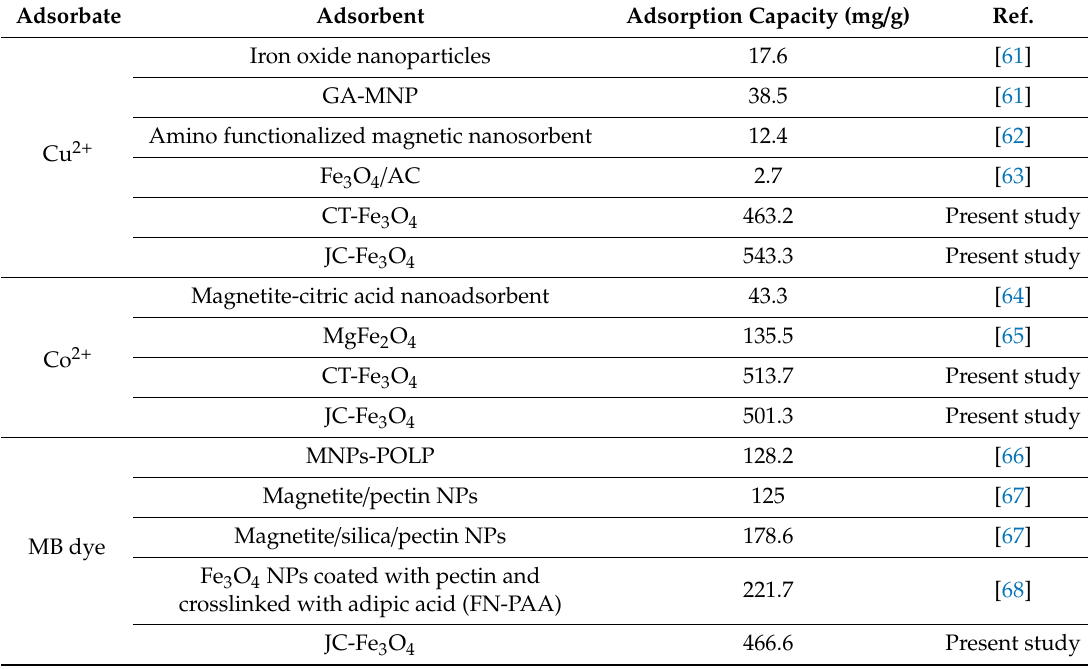
Table 4. Comparison of maximum adsorption capacity of CT-Fe 3 O 4 and JC-Fe 3 O 4 with other magnetite nanoparticle adsorbents literature values.